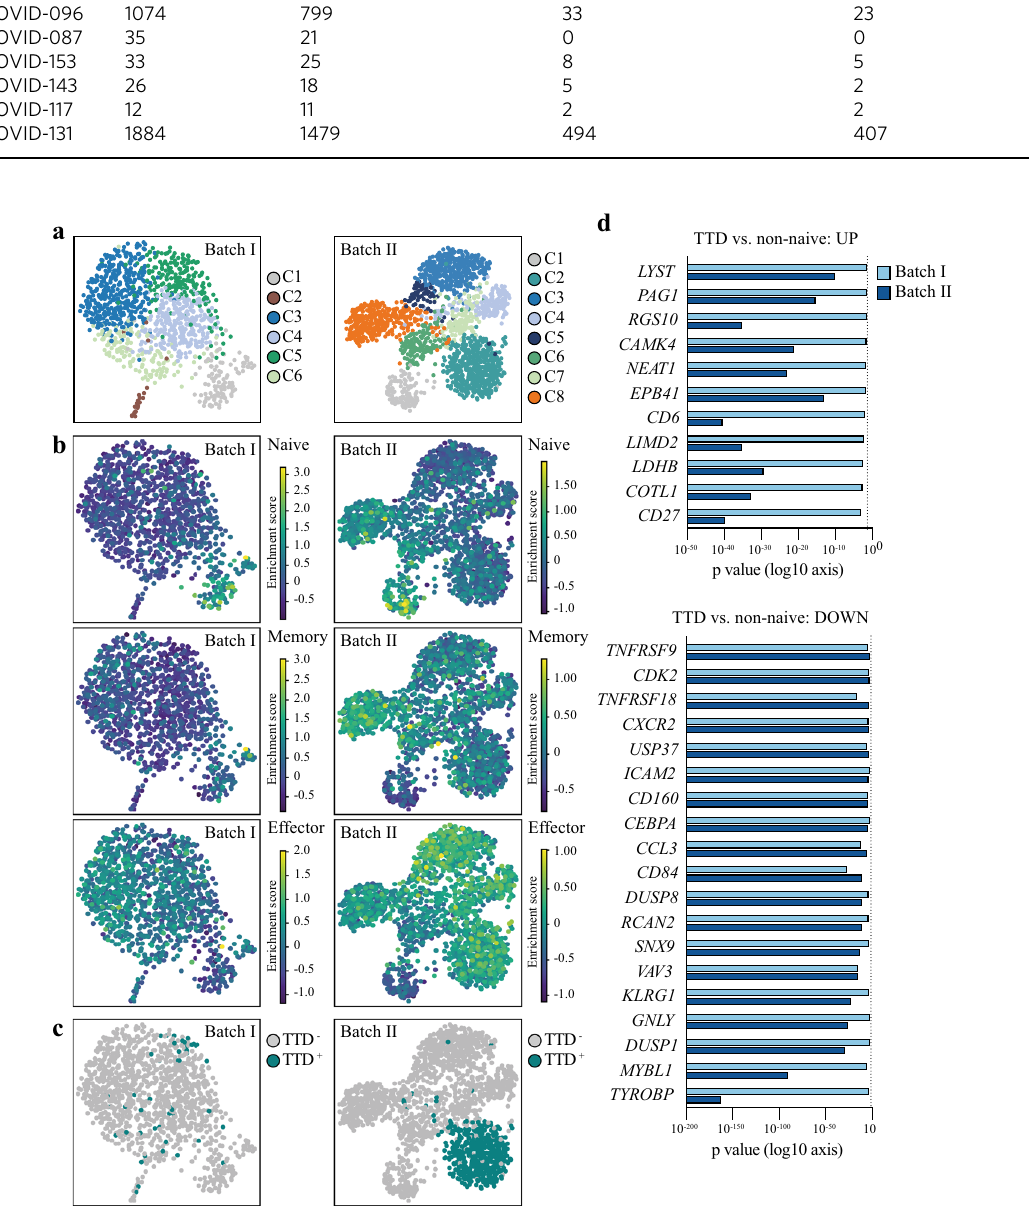
Fig. 4 Single-cell transcriptome analysis of SARS-CoV-2-speci fi c CD8 T cells. a UMAP representations of cell clusters (batch I: n = 6 and batch II: n = 8) of the single-cell gene expression data of CD8 T cells (batch I: n = 1180 and batch II: n = 1884) isolated from COVID-19 patients (batch I: n = 5 and batch II: n